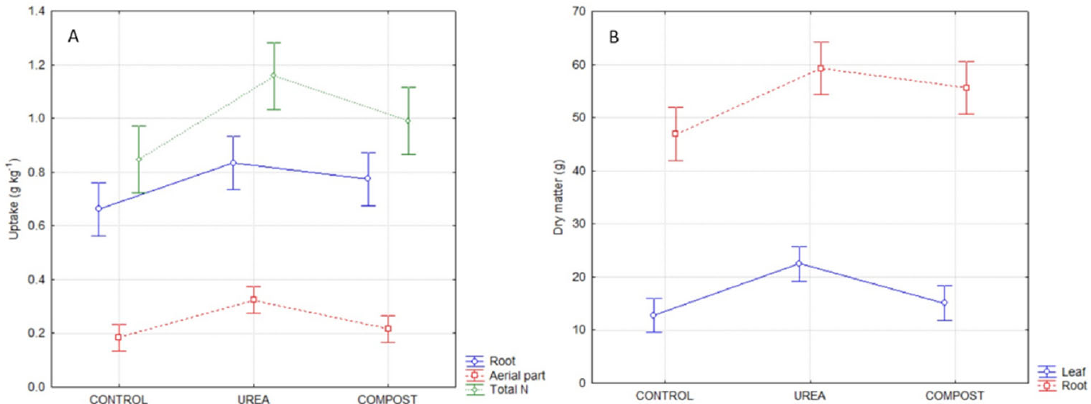
Figure 4. N uptake in aerial part, roots and total ( A ) and dry matter ( B ) of Paspalum notatum cultivated in intercropping with peach trees, with application of urea and organic compost. Two-way ANOVA. Tukey test at 5% probability. The values presented are averages of three replicates per treatment and the vertical bar represents the standard error.